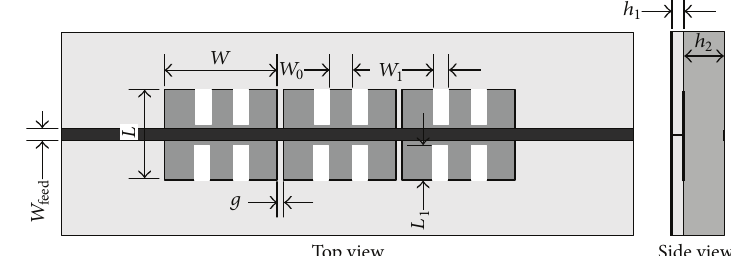
Figure 2: Figures of the three-cell DEP-EBG filters.